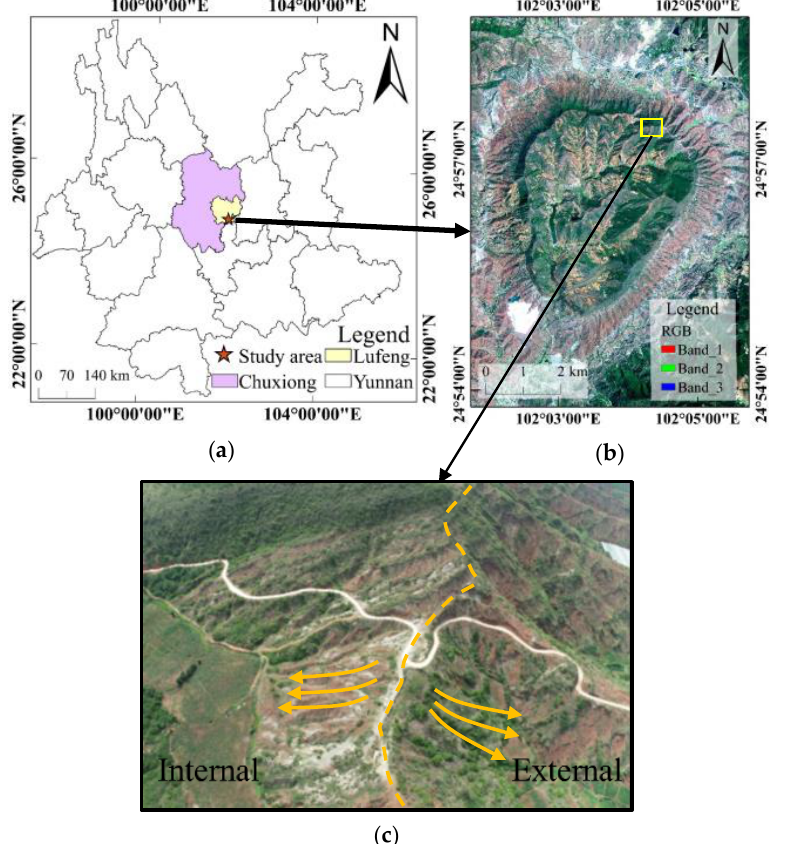
Figure 1. ( a ) Location of Lufeng; ( b ) Satellite image of the study area; ( c ) Complex pit-rim at the entrance.